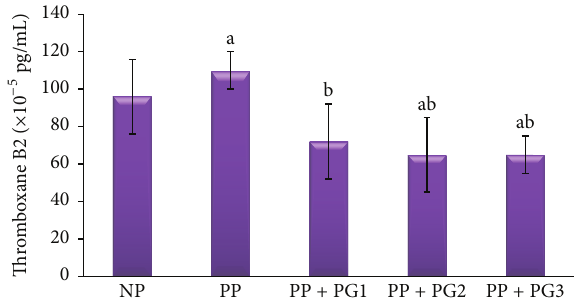
Figure 3: The level of thromboxane B2 in endothelial cells of each experimental group. Values are presented as mean ± SD; a 𝑃 < 0.05 in comparison with endothelial cells exposed to 2% plasma from normal pregnancy (NP) group; b 𝑃 < 0.05 in comparison with endothelial cells exposed to 2% plasma from preeclamptic patients (PP) group; PP + G1: first-dose Punica granatum administered group; PP + G2: second-dose Punica granatum administered group; PP + G3: third-dose Punica granatum administered group; pg/mL: